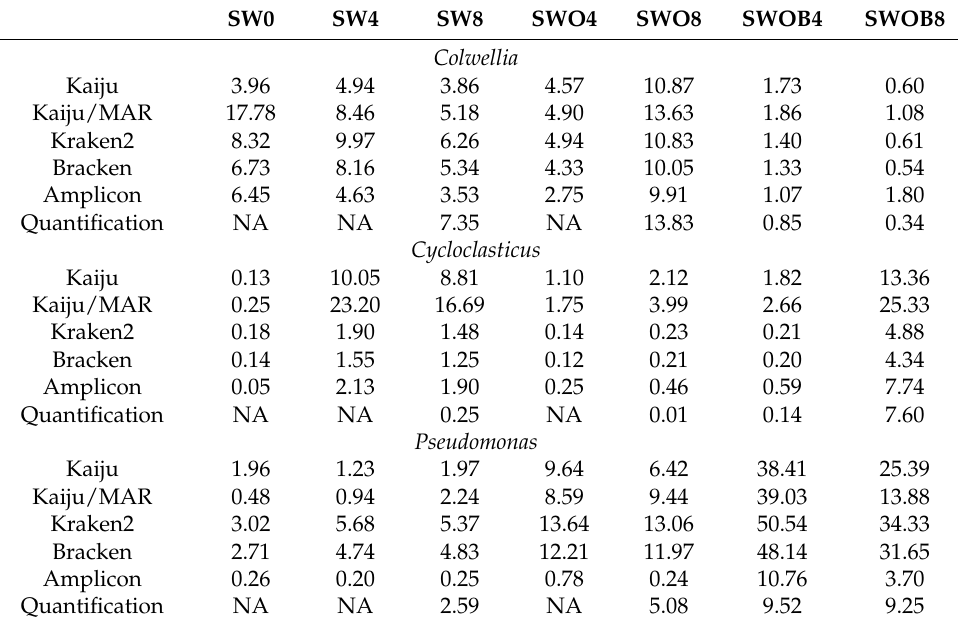
Table 1. The proportions (%) of genera Colwellia , Cycloclasticus , and Pseudomonas in the bacterial community of seawater (SW), oil-contaminated seawater (SWO), and biostimulated oil-contaminated seawater (SWOB) based on five taxonomic classification methods and quantification by qPCR (quan- tified abundances normalized against B16S). The numbers in sample codes denote experimental time in months. NA—not